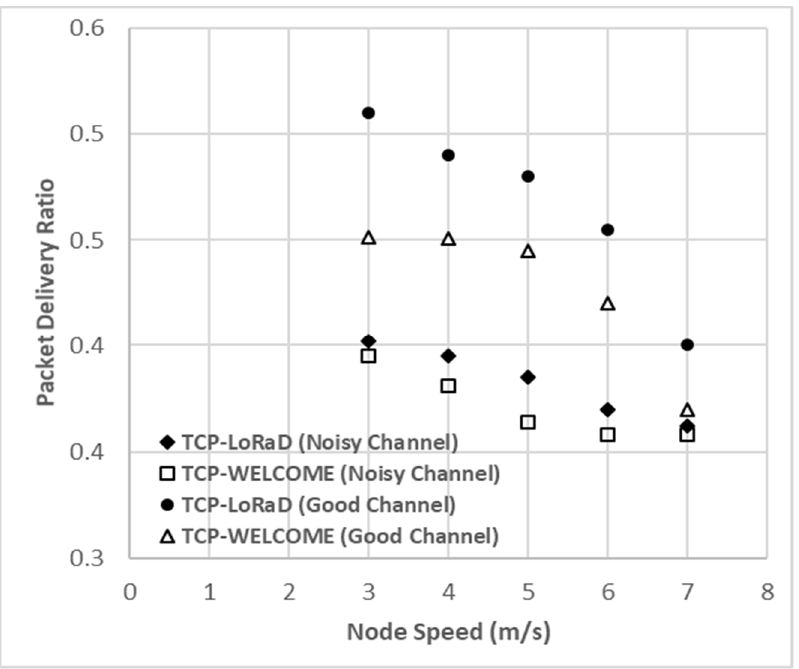
Figure 11. Packet Delivery Ratio versus node speed in a noisy channel. Comparison of TCP-LoRaD and TCP-WELCOME.